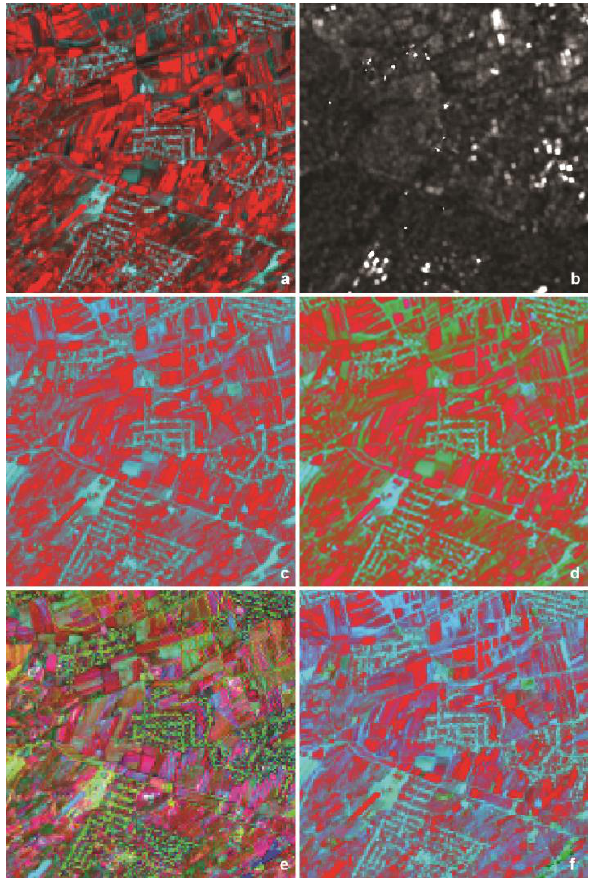
Figure 3. Landsat 8 image (a), Sentinel 1 image (b), Wavelet fusion (c), Ehlers fusion (d), PCA fusion (e), Gram-Schmidt fusion (f). Band combination: NIR, Red,